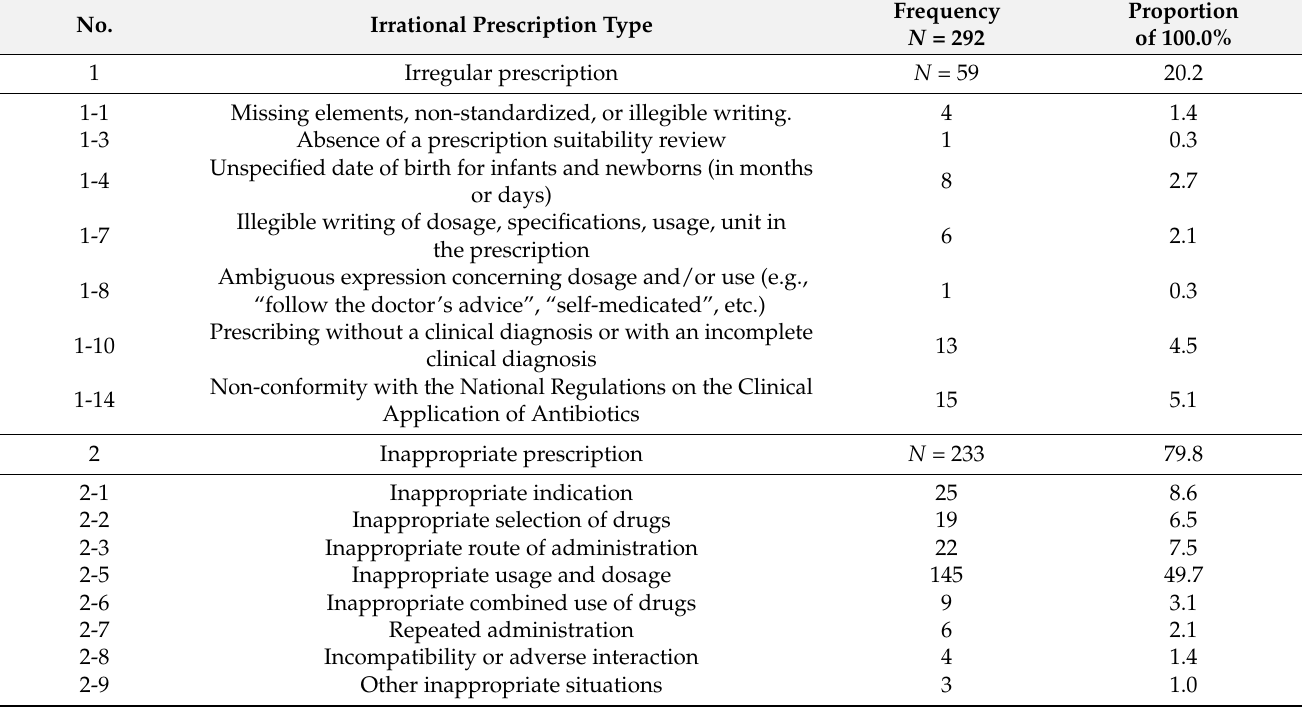
Table 2. Frequency of three types of irrational prescription of sample antibiotic prescriptions for children,